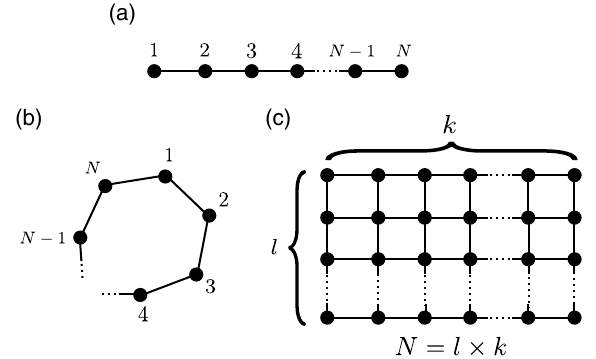
FIG. 2. Representatives of the graphs associated to the classes of states that have been studied with the SDP method: (a) linear graph states, (b) loop graph states, (c) 2D cluster